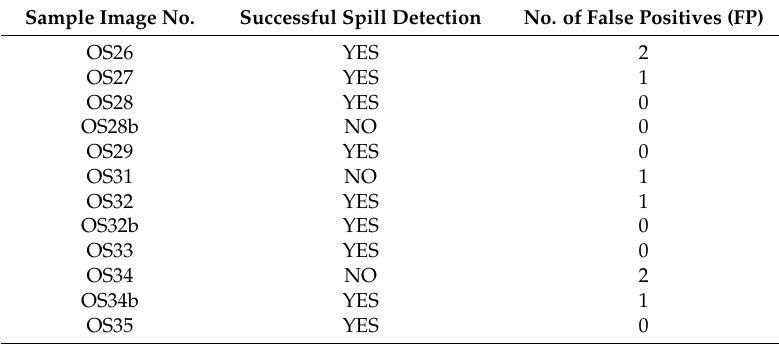
Table 2. Spill Detection Algorithm Results on Case Images. Sample Image